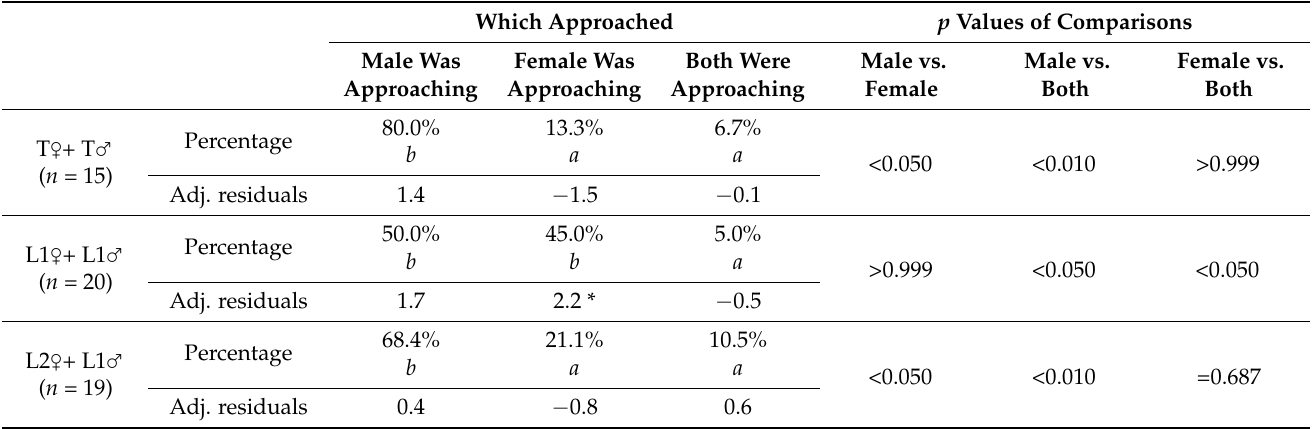
Table 7. Percentage of cases and the adjusted standardized residuals when the male or the female approached the other thrips, or both of them were moving towards the other in the interaction event that led to successful mating. Which Approached p Values of Comparisons Male Was Female Was Both Were Male vs. Male vs. Female vs. Approaching Approaching Approaching Female Both Both